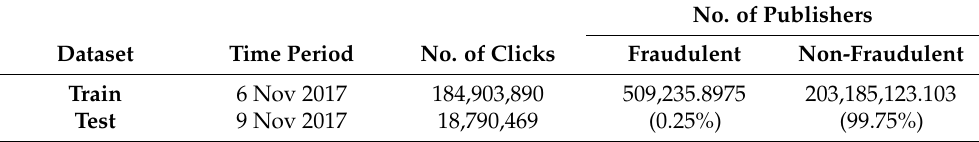
Table 4. Statistics of the TalkingData dataset.